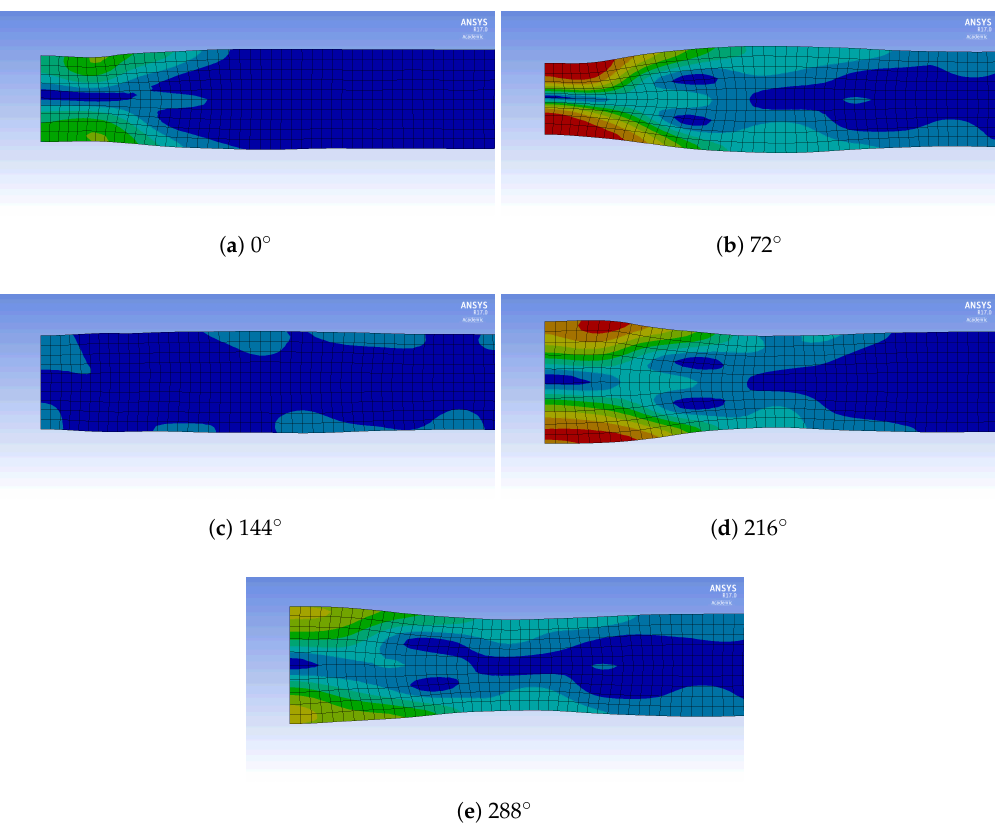
Figure 14. Total deformation at different phase angles (red maximal deformation and blue minimal deformation) at 271 kHz; element edge length: 1 mm; left edge: rotational axis.